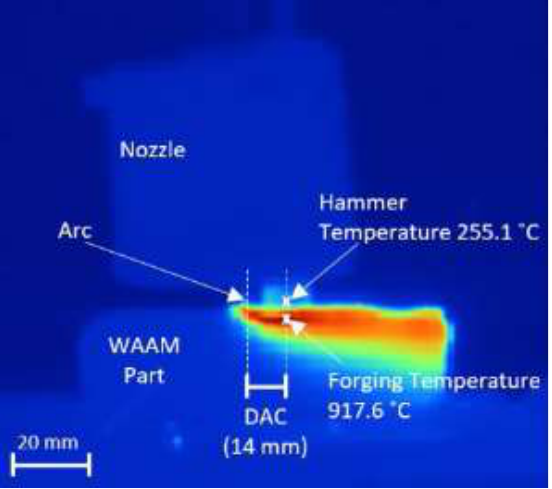
Figure 16. Thermographic analysis of the deposited layer, adapted from